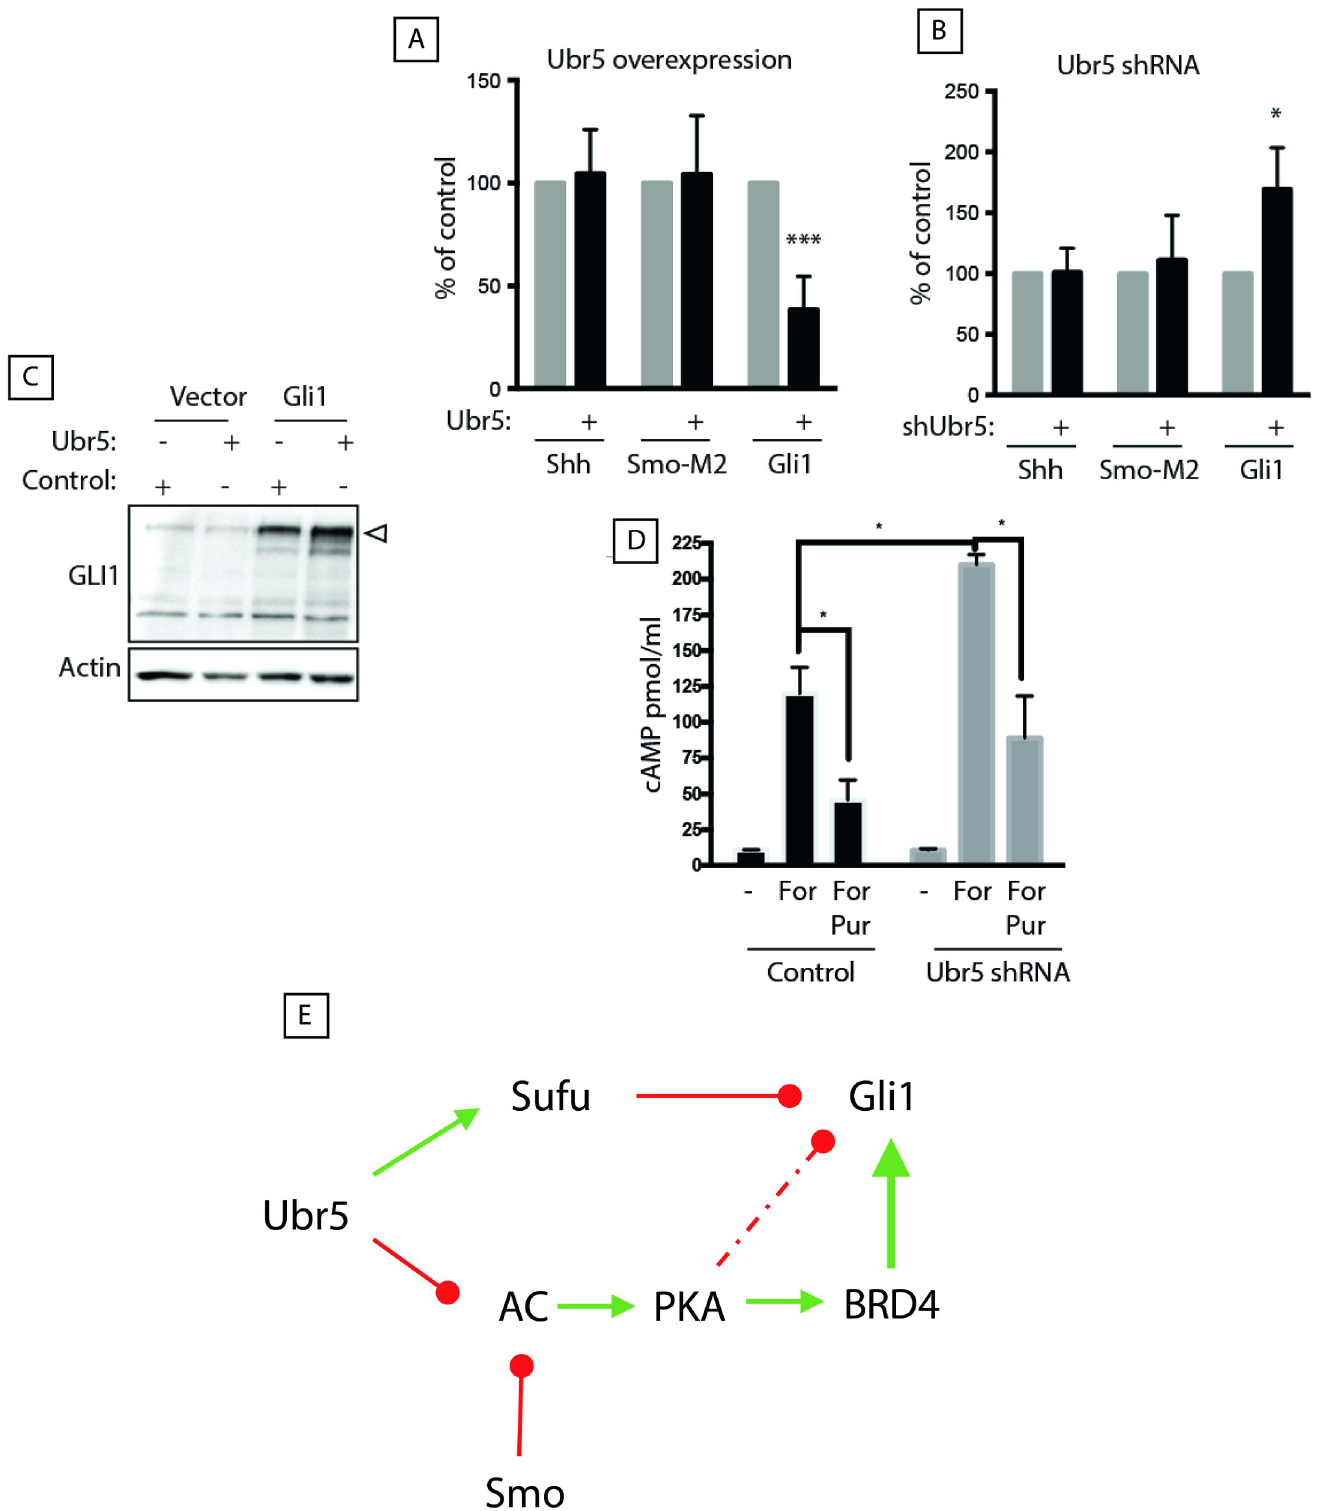
Fig 9. Ubr5 functions as a negative regulator of HH signalling ex vivo. Analysis of HH pathway activity in murine NIH3T3 cells in response to modulation of Ubr5 expression. (A) Cells were transfected with empty pN21 vector (grey bars) or pN21- Ubr5 (black bars) together with plasmids encoding Shh , Smo-M2 or